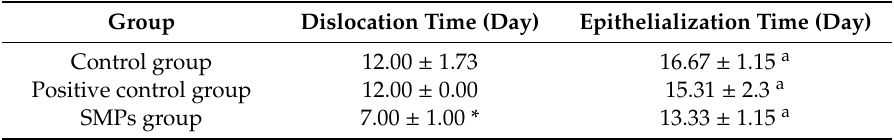
Table 4. E ff ect of SMPs on wound loss and epithelialization (time mean ± S.D.,